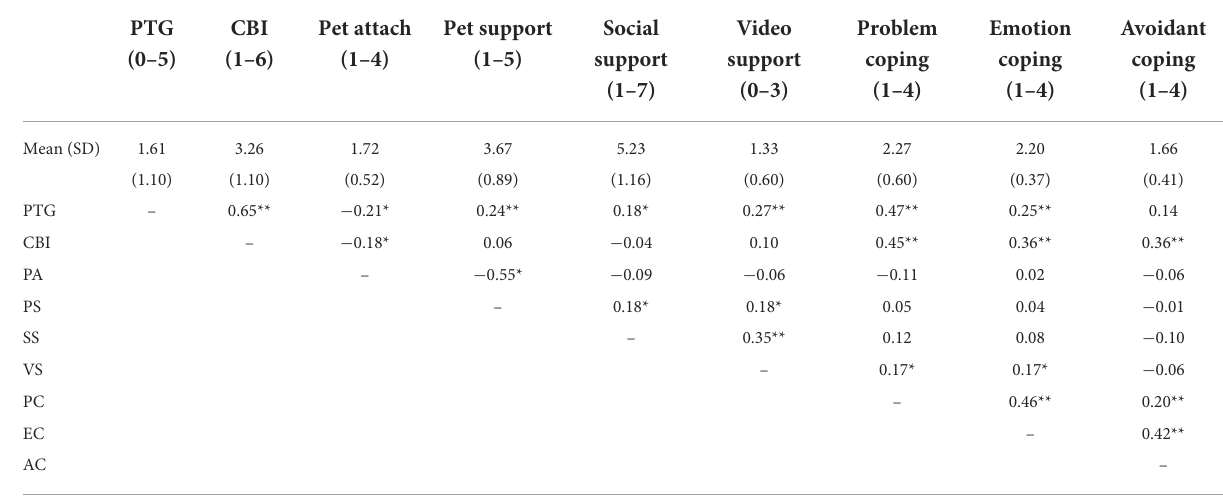
TABLE 2 Correlations and mean scores.